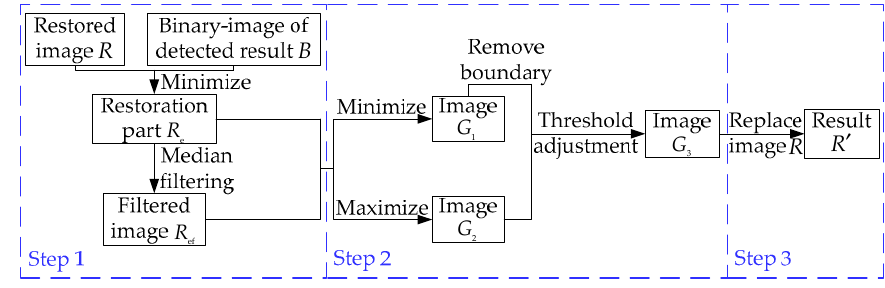
Figure 4. A flowchart of the filtering operation.